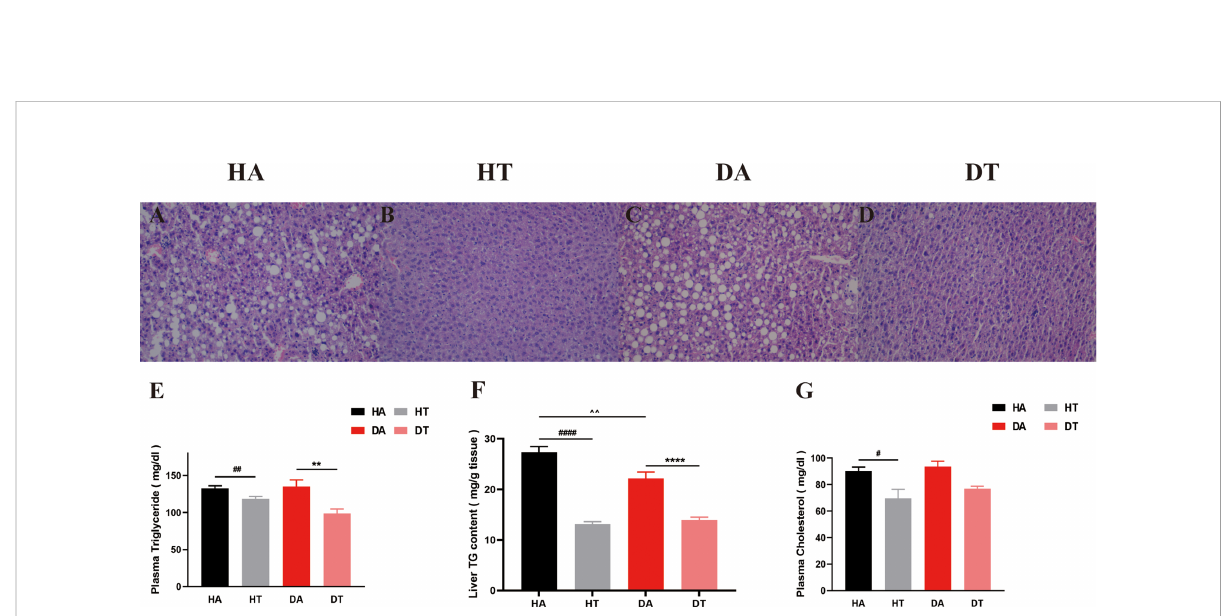
FIGURE 6 Representative liver morphology, triglyceride content in liver, and plasma lipid pro fi les in different groups. (A-D) H&E staining of liver sections (microscope whose magni fi cation: ×20). (E) Triglyceride levels in plasma. (F) Triglyceride content in the liver. (G) Plasma cholesterol levels. All data were presented as mean ± SEM. **P < 0.01, ****P < 0.0001, DA group vs. DT group; # P < 0.05, ## P < 0.01, #### P < 0.0001, HA group vs. HT group. ^^P < 0.01, DA group vs. HA group.